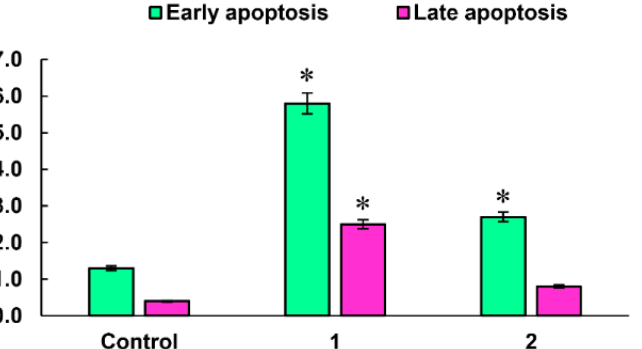
Figure 3. Representative histograms for the numbers of cells (% of total) in the early and late stages of apoptosis for the control and experimental groups. 1 – 2а at IC 50 /2 concentration (12.5 µM); 2 – 2а at IC 50 concentration (25 µM). The values are presented as the mean ± SD; ( ∗ ) p < 0.05 compared to control.